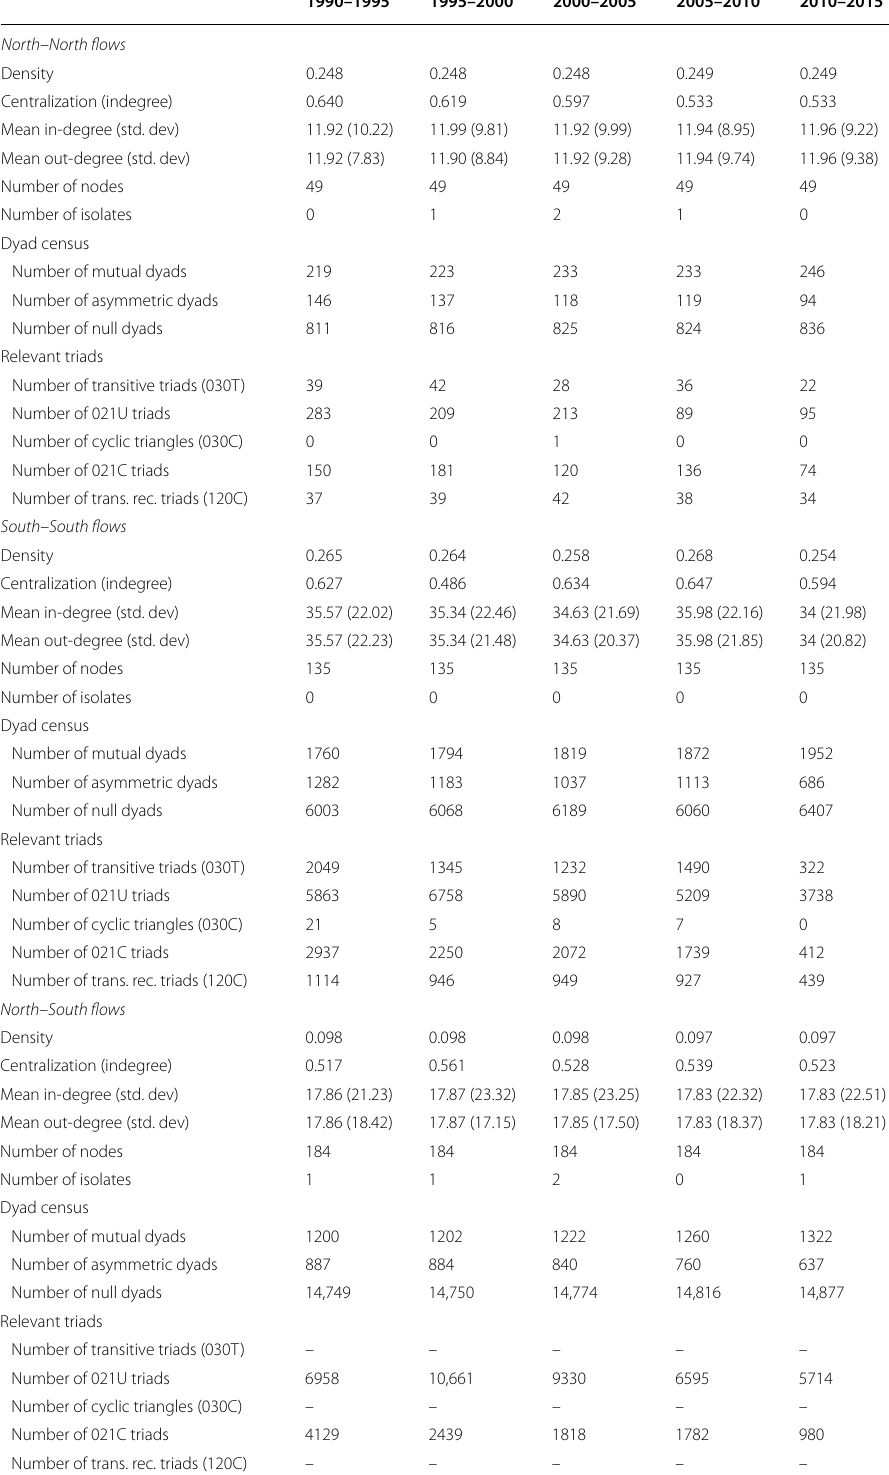
Migration flows included here are those in the top quartile of flows arranged by size in each migration